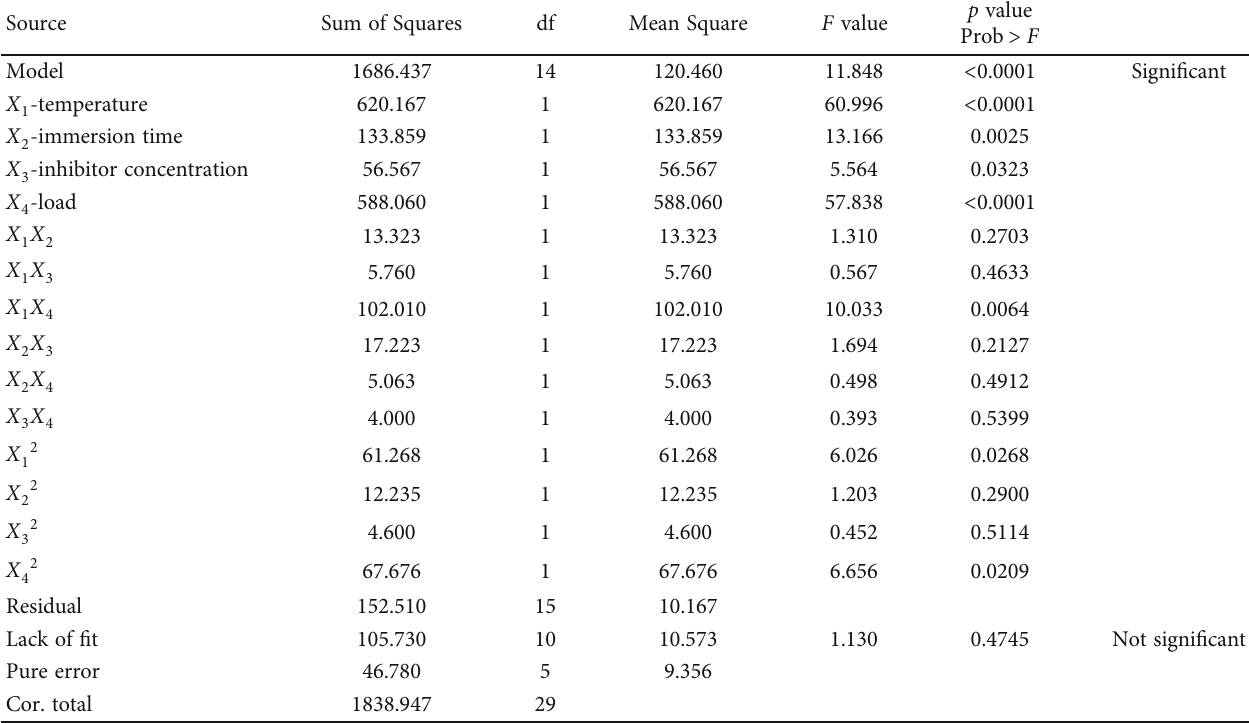
Table 8: Type III ANOVA result for Young